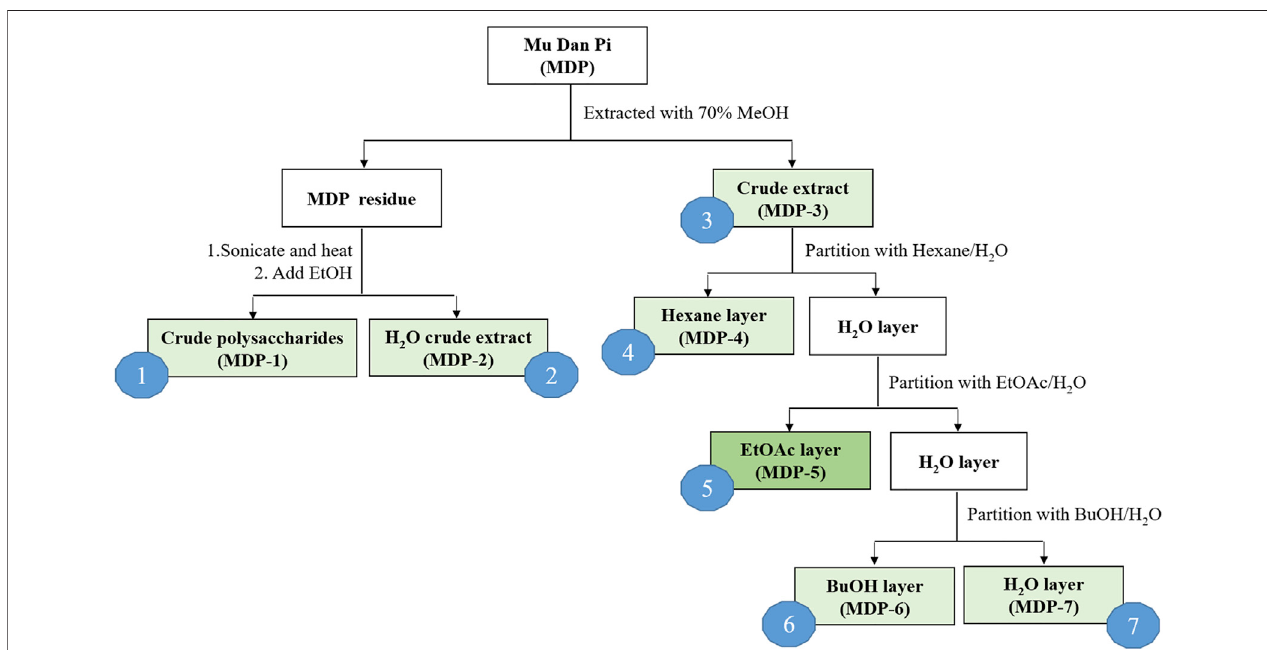
FIGURE 1 | Flow chart of the preparation procedures for MDP